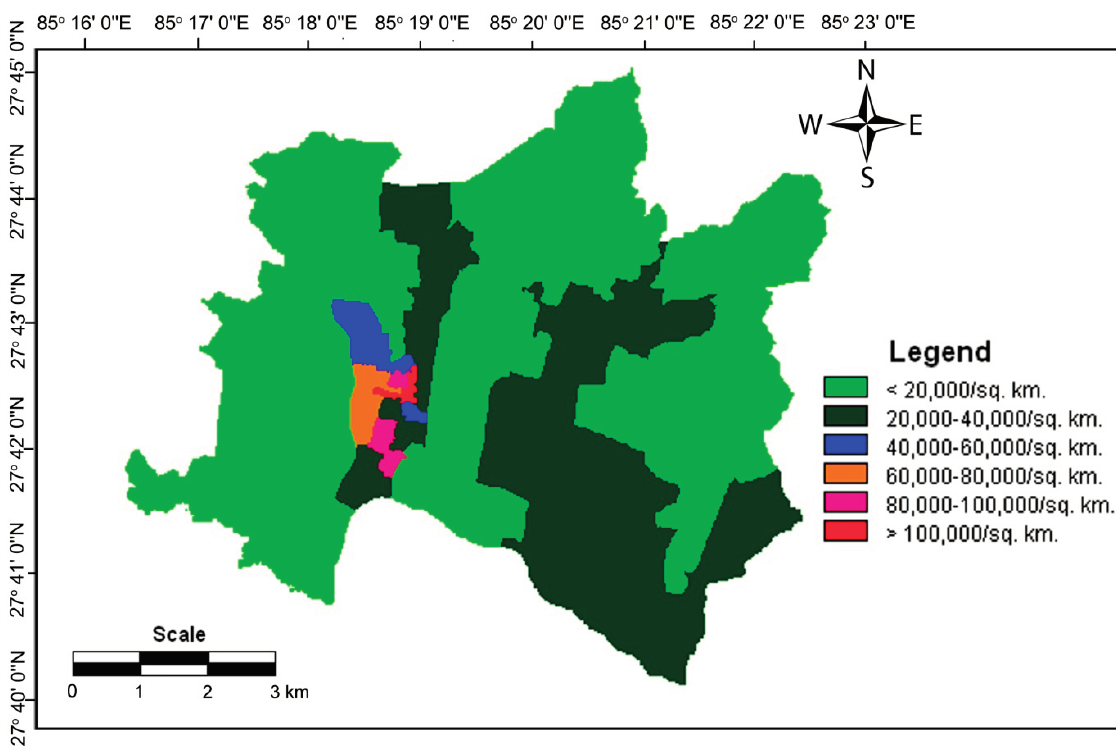
Figure 5. Map showing population density of Kathmandu Metropolitan